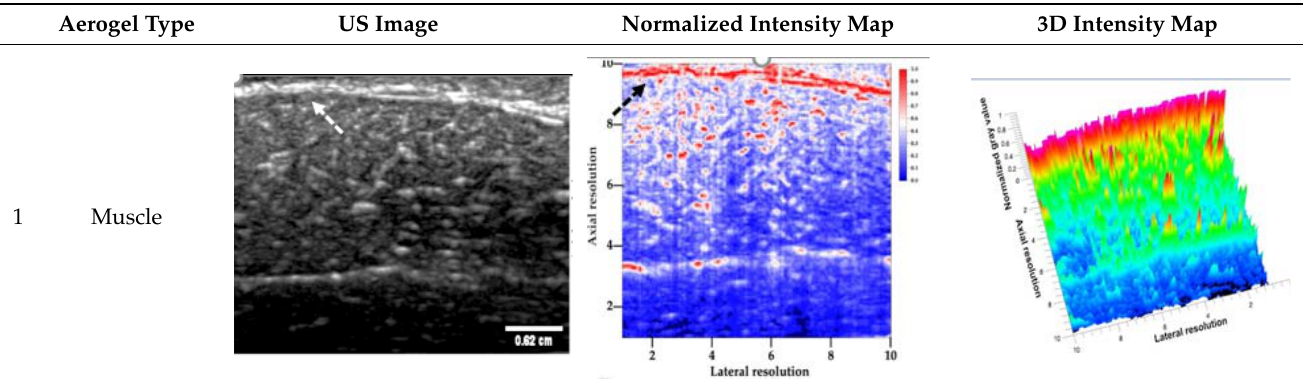
Table 5. US images and intensity maps of each aerogel type used in this study at a scan frequency of 6.5 MHz.